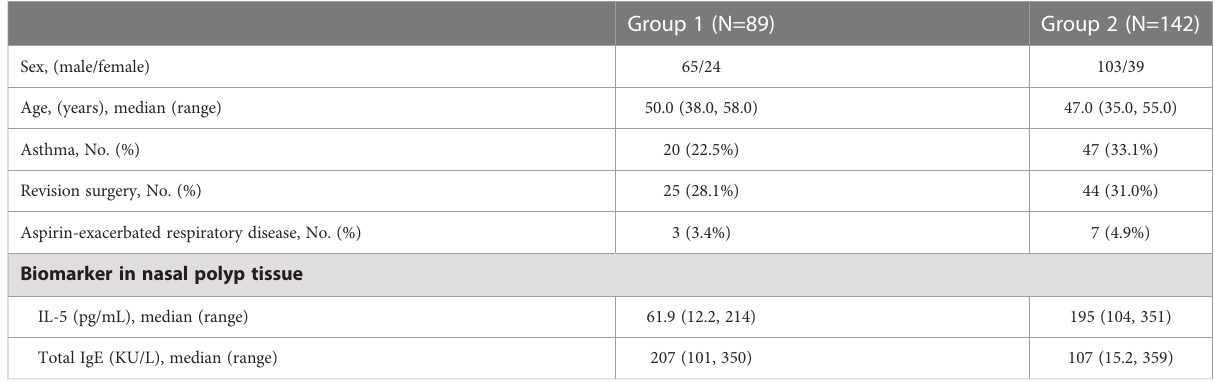
TABLE 1 Patient